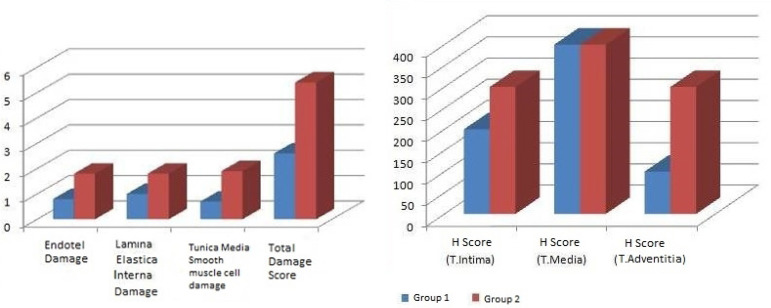
Histological evaluation results of saphenous vein wall structure. As shown in A, there was a significant difference between the groups in the 'total damage score' (P<0.001). In H-score evaluation, there was no statistically significant difference between the groups in terms of tunica (T) intima and T media, however, as shown in B, a significant difference was determined between the groups in terms of T adventitia.